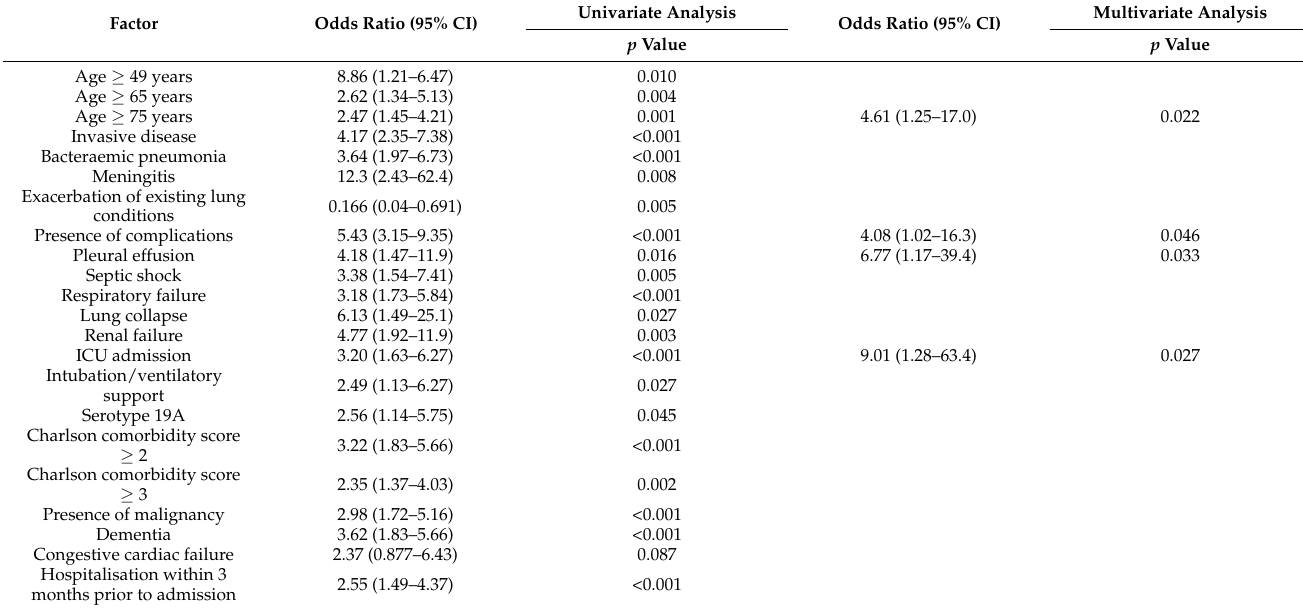
Table 7. Risk factors associated with 30-day mortality by univariate and multivariate analysis. Factor Odds Ratio (95% CI)